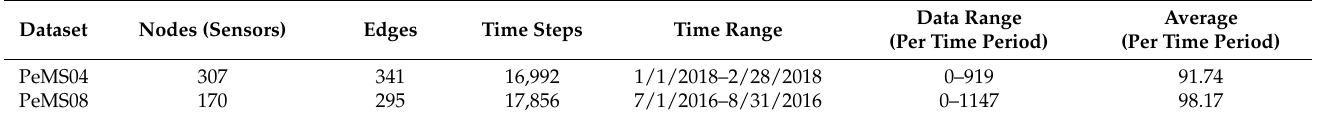
Table 1. Details of the